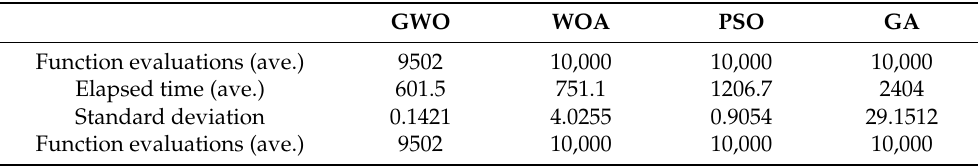
Table 8. Statistical results of the performance of each algorithm in all runs. GWO WOA PSO GA Function evaluations (ave.) 9502 10,000 Elapsed time